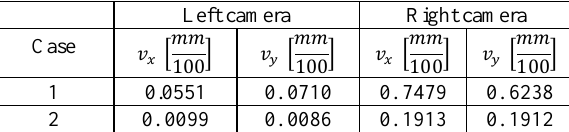
Table 3. RMS of the image coordinate residuals (x = horizontal, y = vertical) for the bundle adjustment with the interior orientation not fixed.